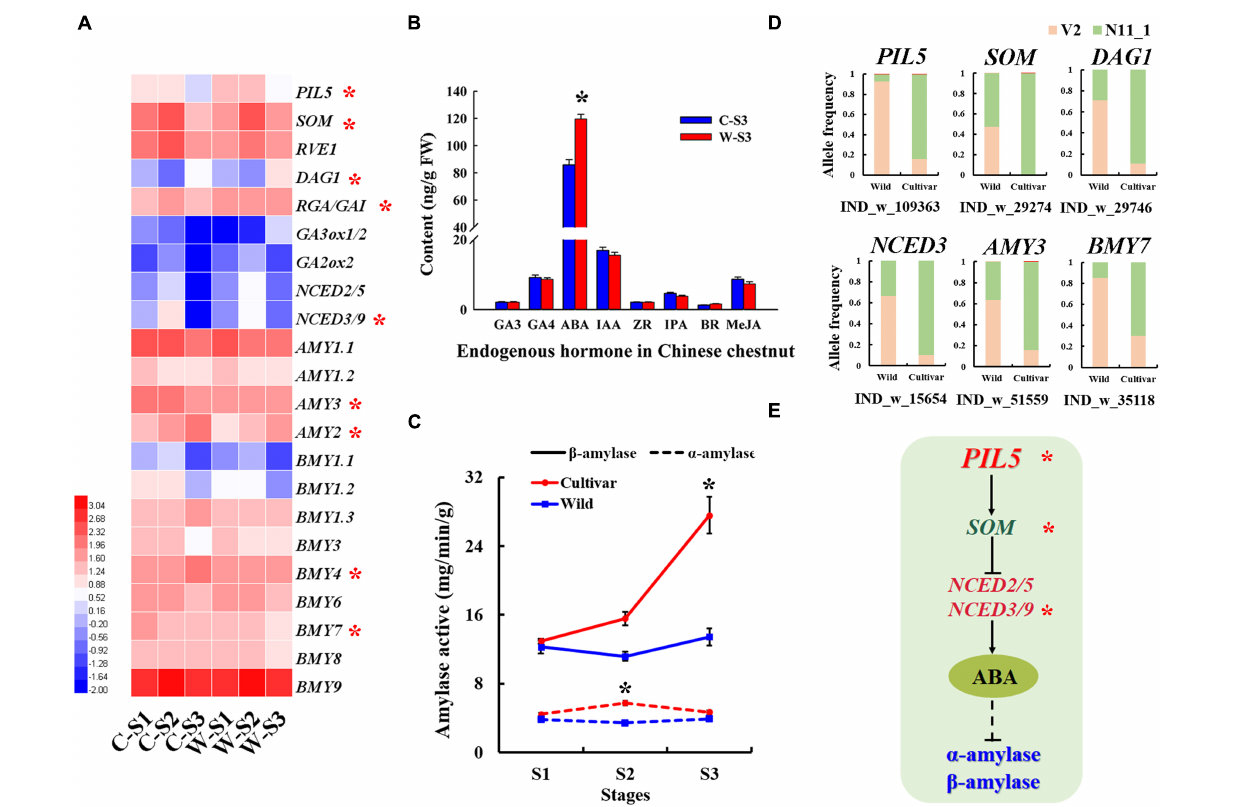
FIGURE 4 | Selected amylase genes associated with the germination of Chinese chestnut seeds. (A) Seed germination-related gene expression profiles of Chinese chestnut, where * indicates a significant difference at P < 0.05. (B) Levels of endogenous hormones in Chinese chestnut at seed germination stage S3, where * indicates a significant difference at P < 0.05. (C) Alpha-amylase and beta-amylase activities in seed germination stages of wild and cultivated Chinese chestnut seeds; * indicates a significant difference at P < 0.05. (D) The allele frequencies of selected SVs in wild and cultivated Chinese chestnut. (E) The model of seed germination regulation by ABA synthesis pathway genes under strong selection in Chinese chestnut; * indicates the significance of the key genes.